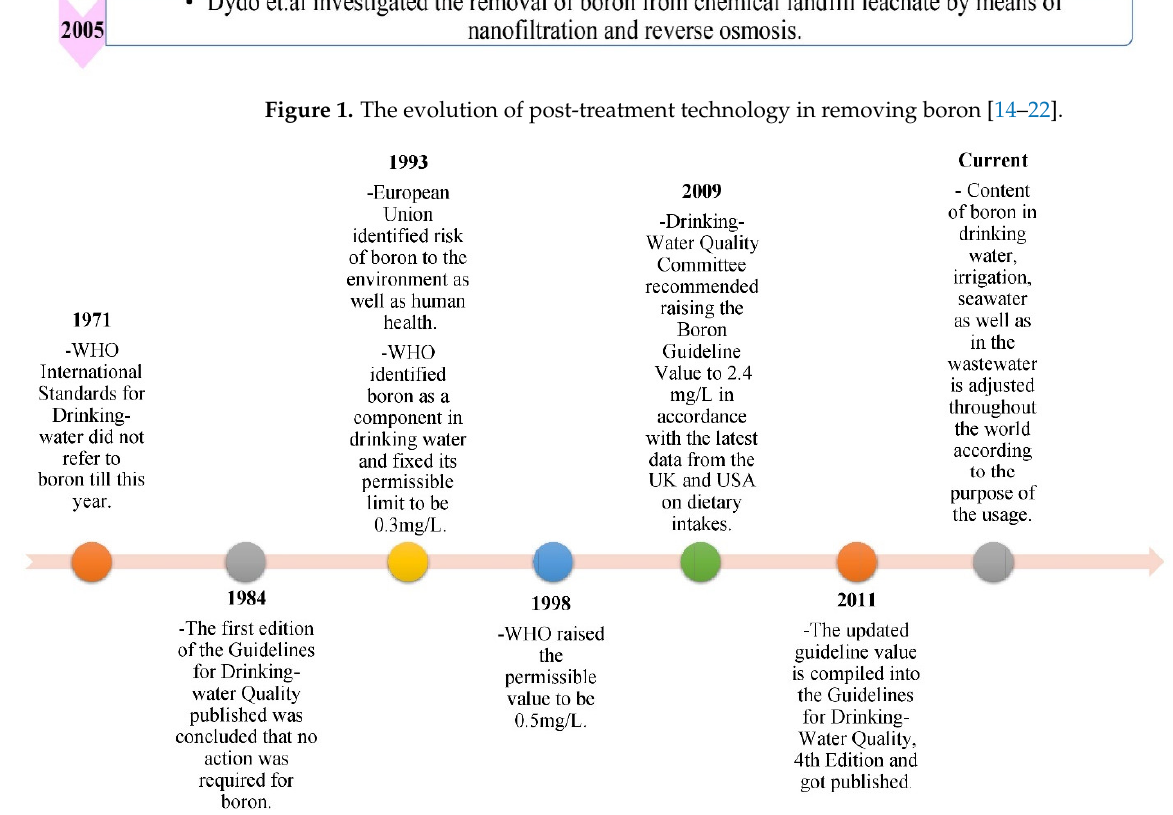
Figure 2. The progress of standards permitted for boron in drinking water [25]. Table 1. Boron hazard for irrigation water (ppm = part per million). Reprinted with permission from Ref. [27], 1994, Elsevier.